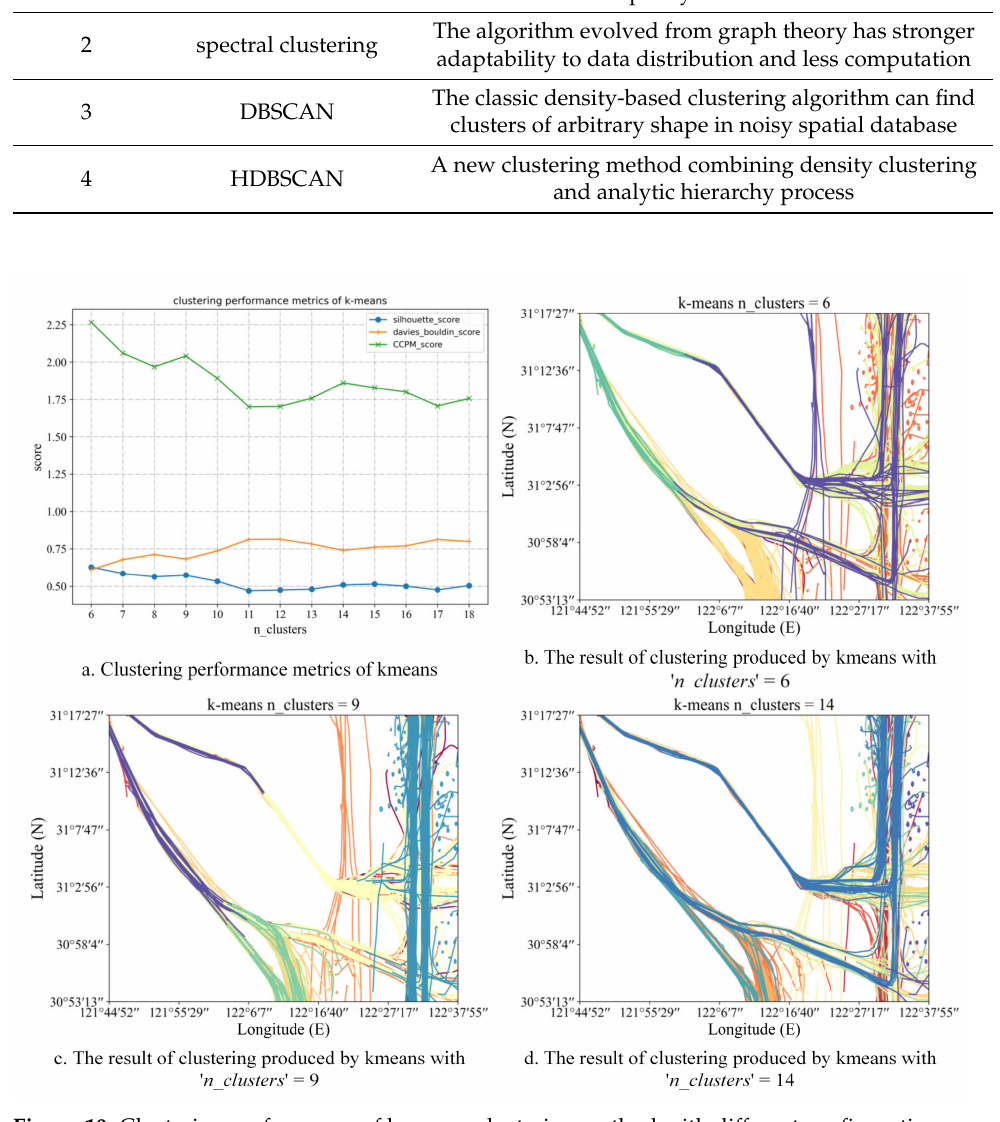
Figure 10. Clustering performance of k-means clustering method with different